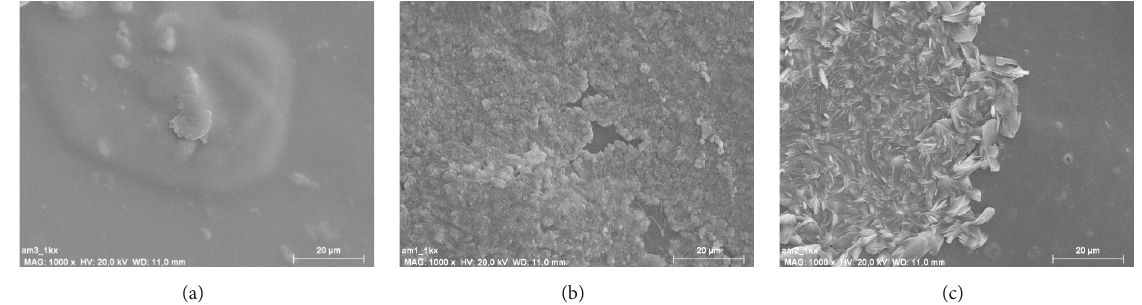
Figure 2: Scanning electron microscopy images of the membranes: (a) chitosan membrane, CB0; (b) chitosan membrane prepared with the first extract, CB1; and (c) chitosan membrane prepared with the third extract,